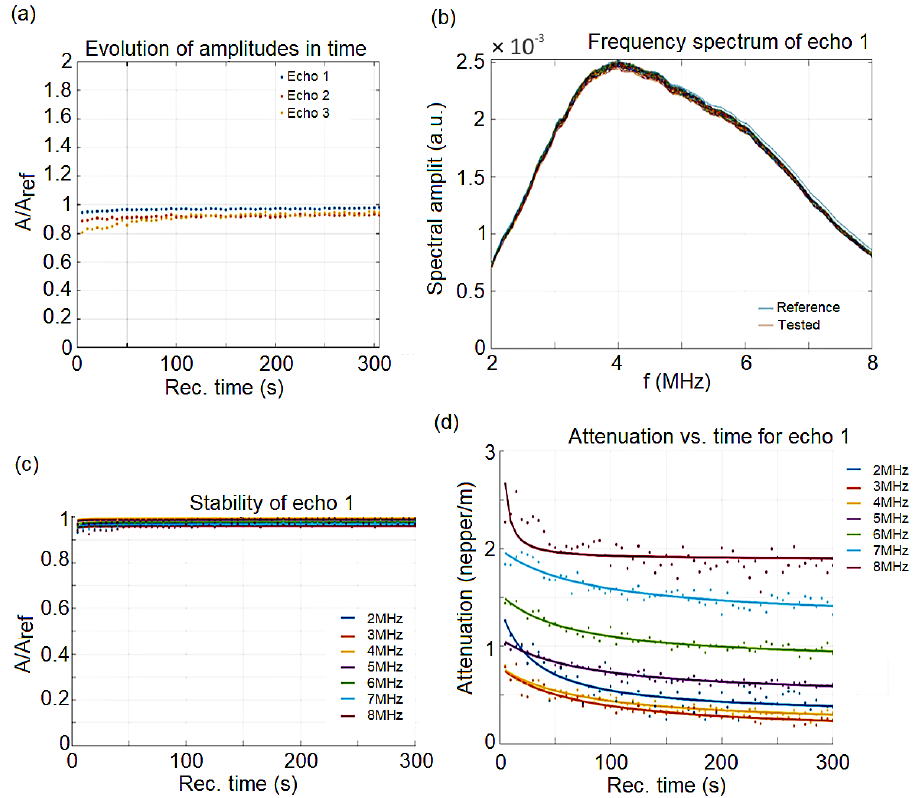
Figure 4. ( a ) Relative amplitudes evolution vs. the recording moments; ( b ) Frequency spectrum of the first transmitted echo. Reference fluid (-); ( c ) Spectral amplitudes relative variation vs. time, for the first echo; ( d ) Attenuation vs. time for the spectral components of the first echo.